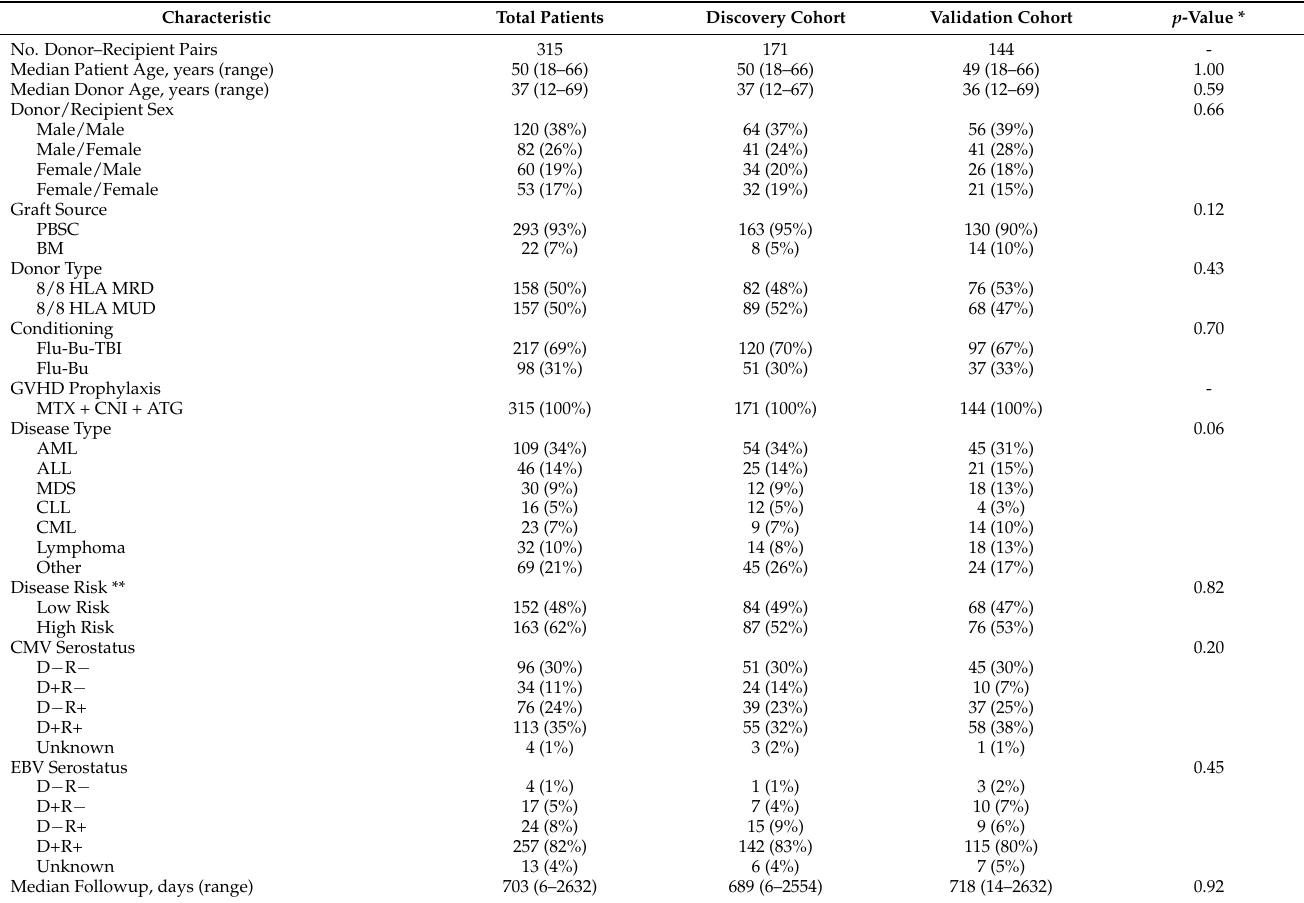
Table 1. Demographic and clinical characteristics of donor–recipient